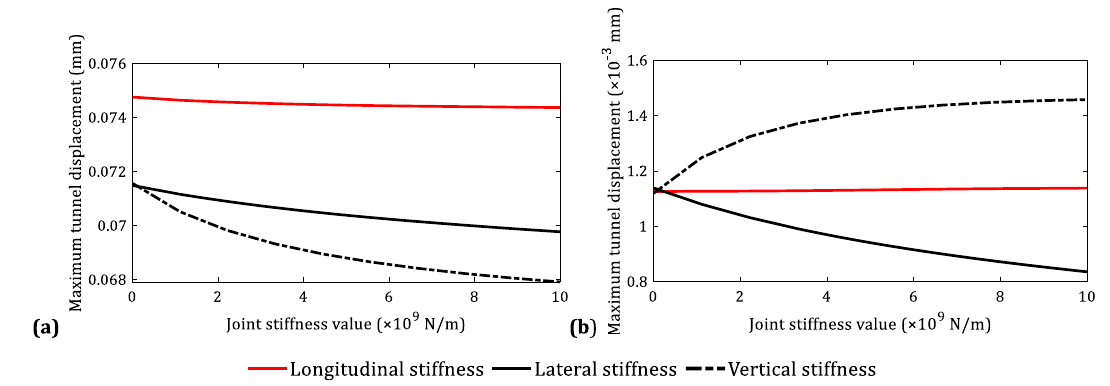
Fig. 19 Influence of tunnel segmental joint stiffness on tunnel vertical displacement: a tunnel bottom segment; b tunnel sidewall